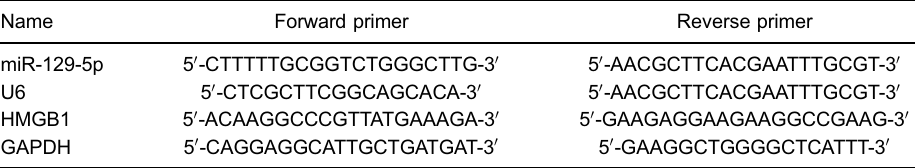
Table 1. Polymerase chain reaction